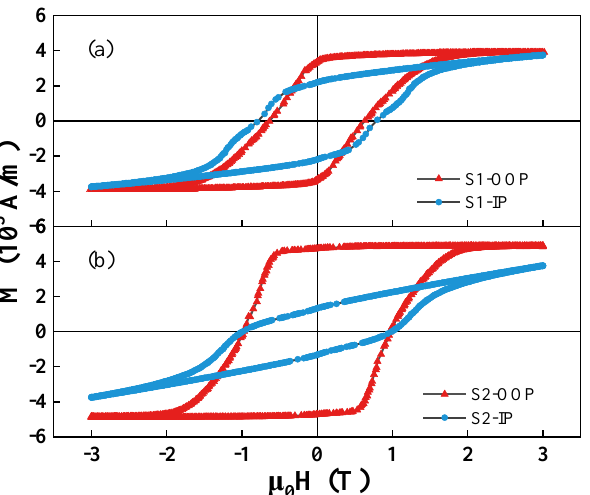
Figure 3. Hysteresis loops of ( a ) S1 sample and ( b ) S2 sample, in out-of-plane (OOP) and in-plane (IP) directions.